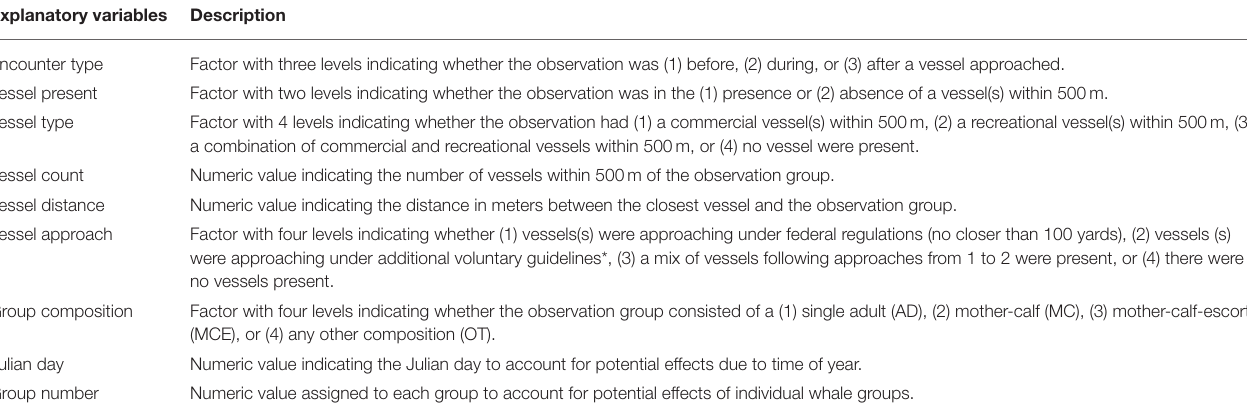
TABLE 1 | List of explanatory variables used in GAM to determine the relationship between vessel activity and humpback whale behavior. Explanatory variables